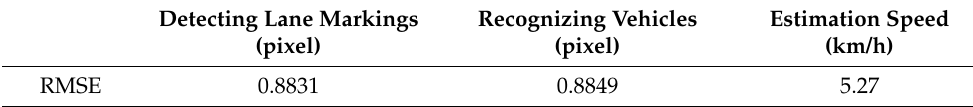
Table 3. Root-mean-square error